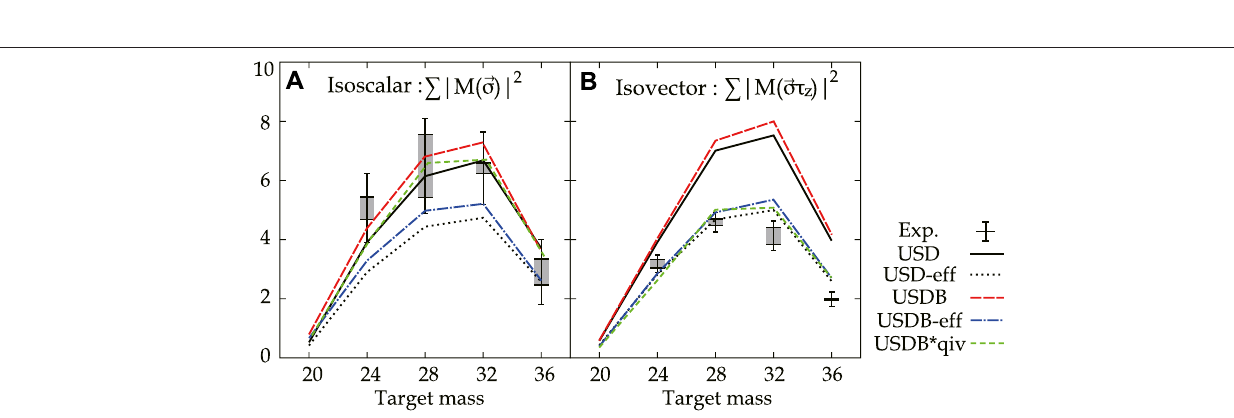
The integrated values of the SNMEs up to E x (cid:1) 16 MeV were plotted as a function of the target mass in Figure 8 for each of the IS (left panel) and IV (right panel) transitions. Error bars show